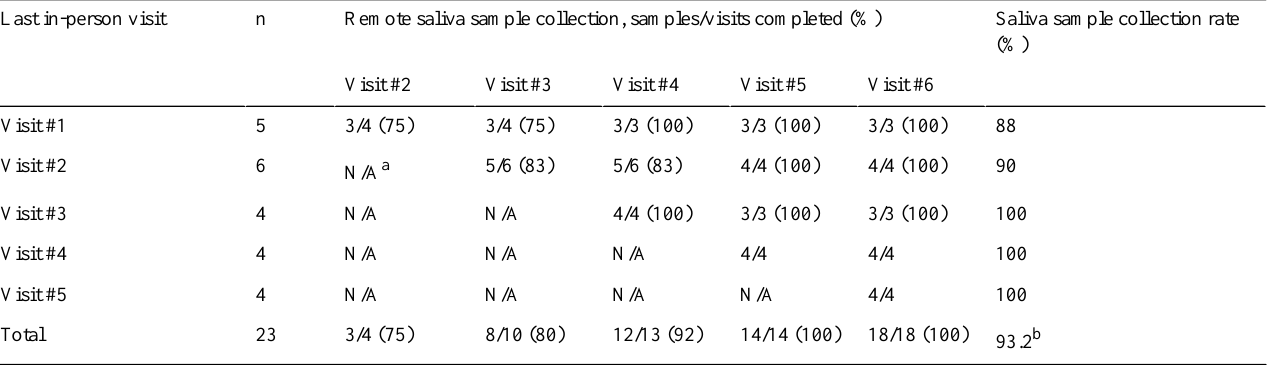
Table 4. Saliva sample collection rates among smoking cessation clinical trial participants by last in-person visit for the COVID-19 cohort